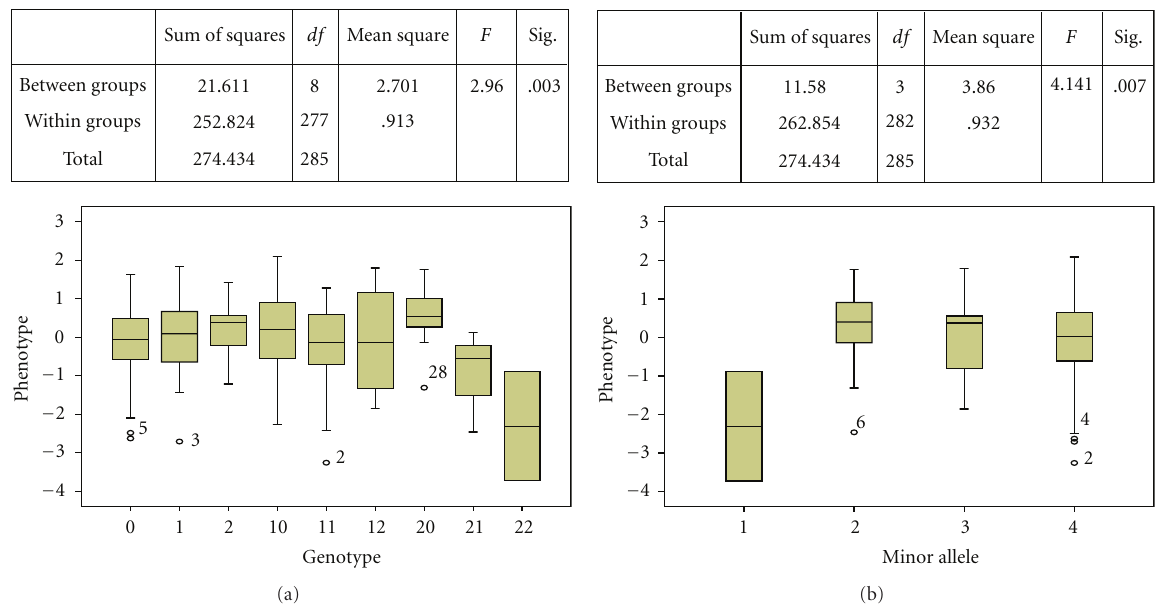
Figure 2: The interaction of an SNP pair from BIN1 and APP is likely to influence logical memory in the APOE ε 4 positive subset of LBC1936. Analysis of both the (a) genotype cognitive means and (b) the allele specific means shows that the initial positive result is due to two individuals carrying both minor alleles, aabb. Genotype legend; 11 = AaBb, 10 = AaBB, 01 = AABb, 00 = AABB, 12 = Aabb, 01 = AAbb, 21 = aaBb, 20 = aaBB, 22 = aabb. Allele legend; 1 = aabb, 2 = aaB-, 3 = A-bb, 4 =